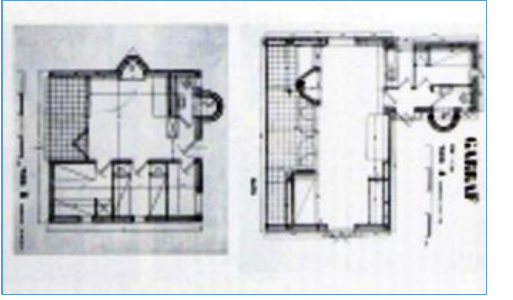
Figure 12. Plan of Week end house